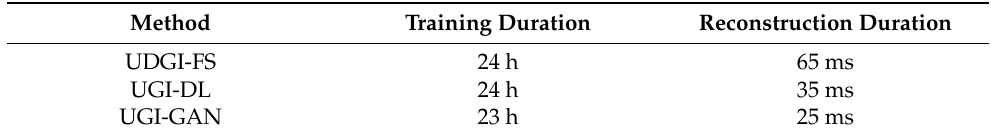
Table 1. The training and reconstruction durations of UDGI-FS, UGI-DL, and UGI-GAN at 20% sampling rate.